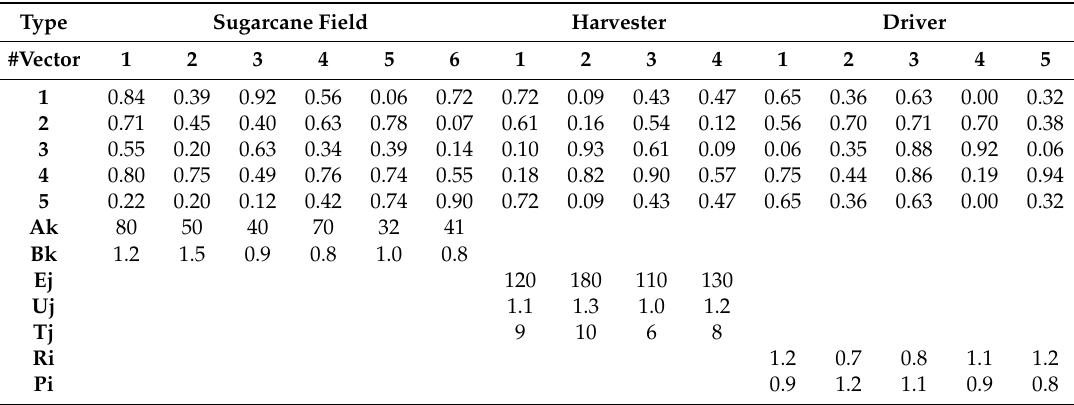
Table 1. Randomly generated target vectors in the first iteration.